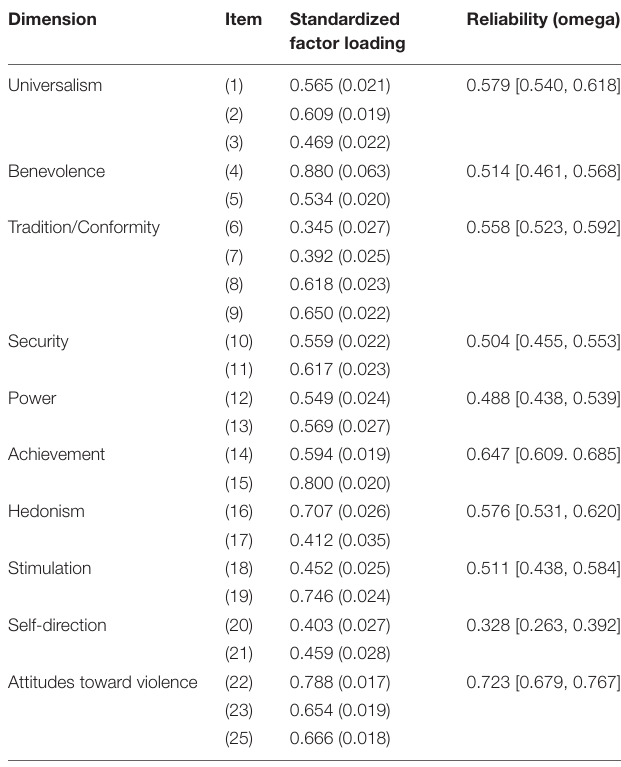
TABLE 2 | Standardized factor loadings and